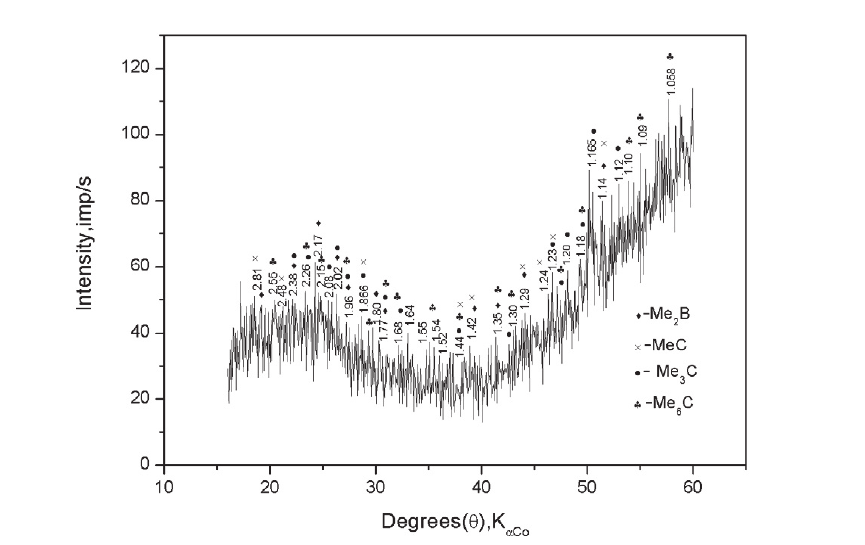
Figure 7: XRD patterns of HS 6-5-2 steel surface after electrical discharge modification in